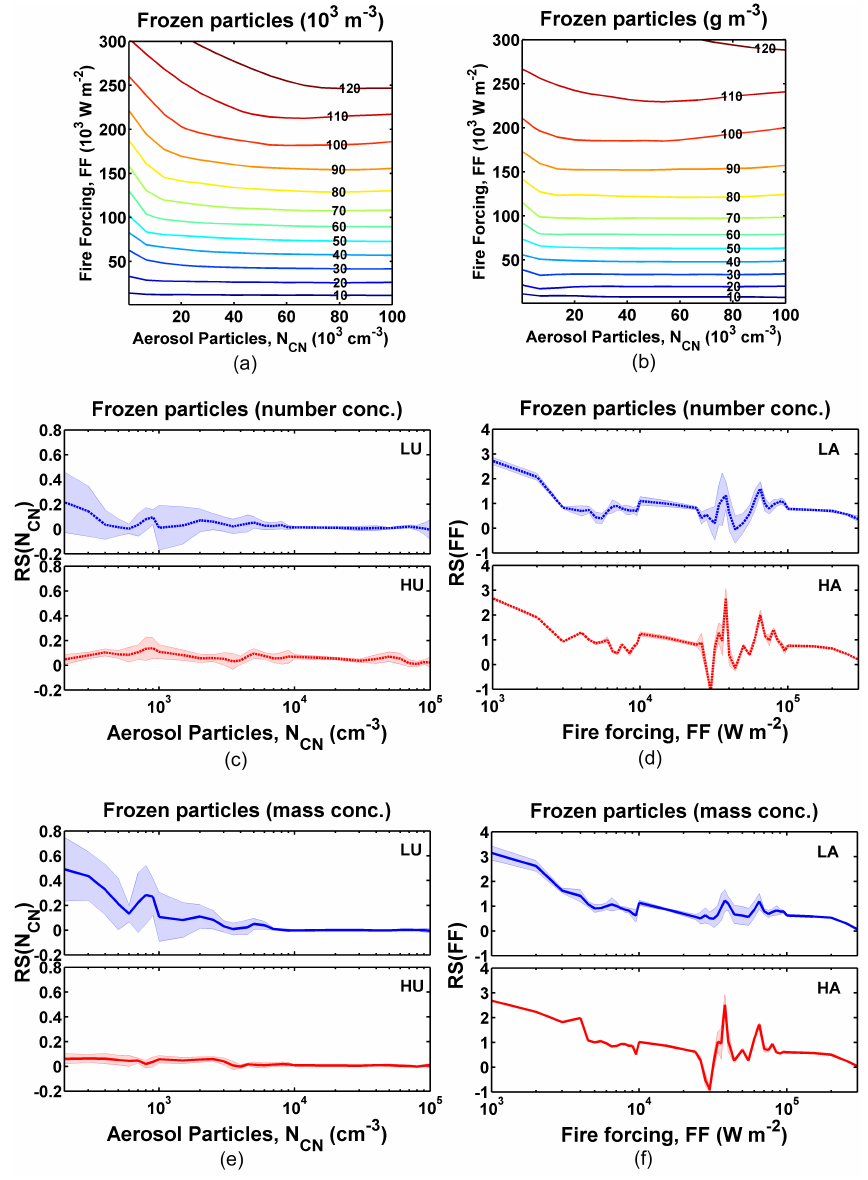
Figure 12. Same as Fig. 7 but for total frozen